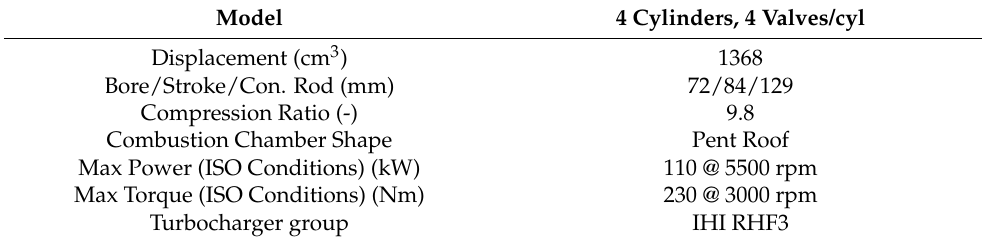
Table 2. Engine main characteristics for gasoline fueling.